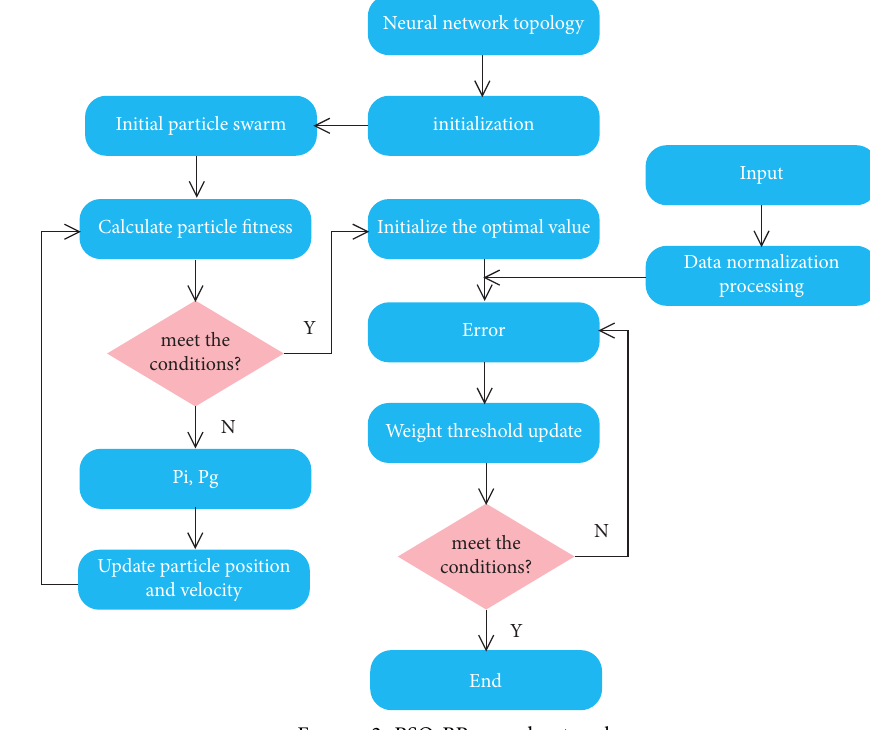
Figure 2: PSO-BP neural